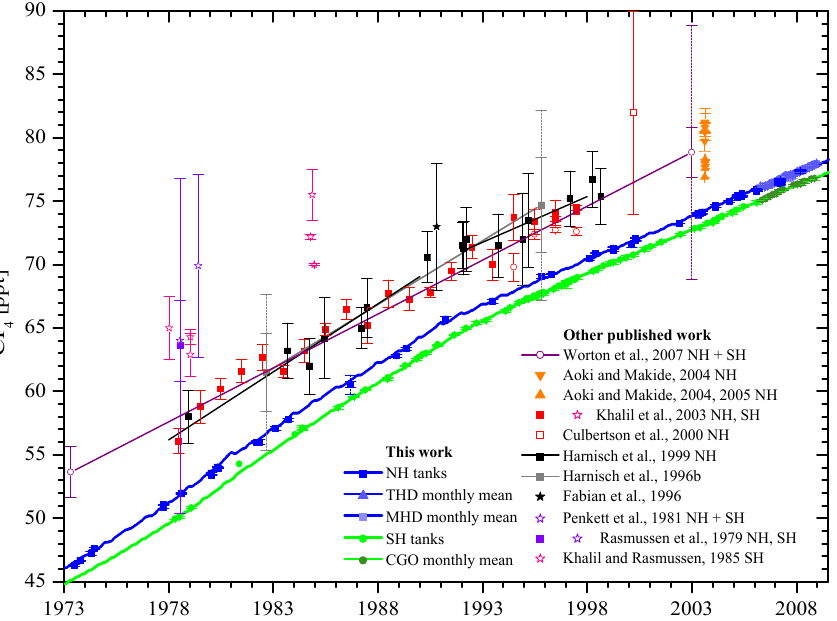
Fig. 1. AGAGE CF 4 abundances from archived Northern Hemisphere (NH) and Southern Hemisphere (SH) air samples and in situ measure- ments at Mace Head, Ireland (NH), Trinidad Head, California (NH), and Cape Grim, Tasmania (SH) and modeled 30–90 ◦ N and 30–90 ◦ S abundances all shown on the SIO-2005 calibration scale compared to previous observations. Uncertainty estimates for the SIO-2005, MPAE 86, and UEA calibration scales are indicated as additional dashed error